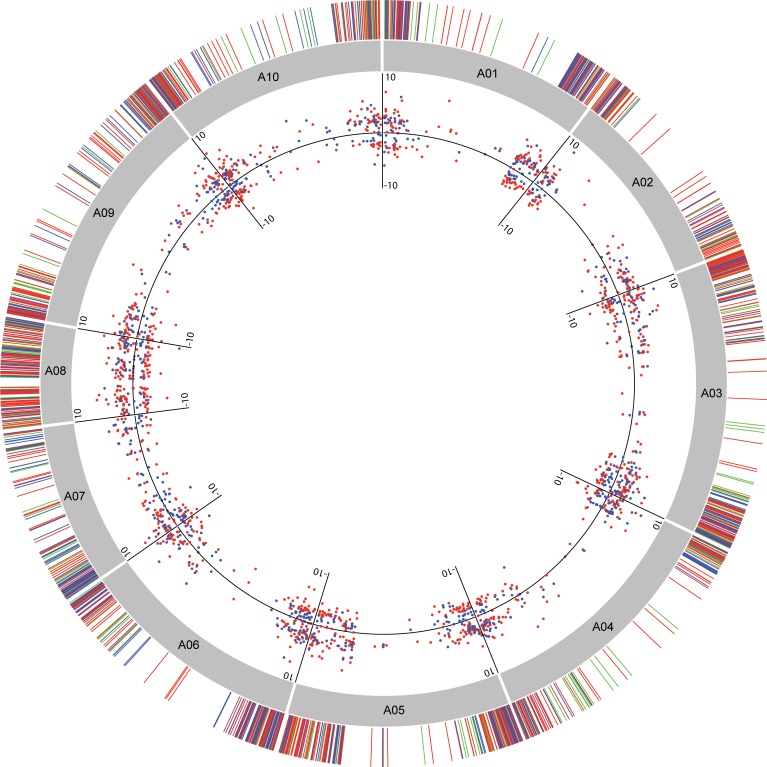
Circos plot detailing chromosome distribution of DEGs.Distribution of the 1,602 DEGs in the ten chromosomes of A. duranensis (A01 to A10). The outer lines represent exclusive A. duranensis (red) and A. stenosperma (blue) and common (green) DEGs. The inner dots represent the distribution of Log2FC values for each up- and downregulated DEG in A. duranensis (red) and A. stenosperma (blue), with the line indicating Log2FC = 0.